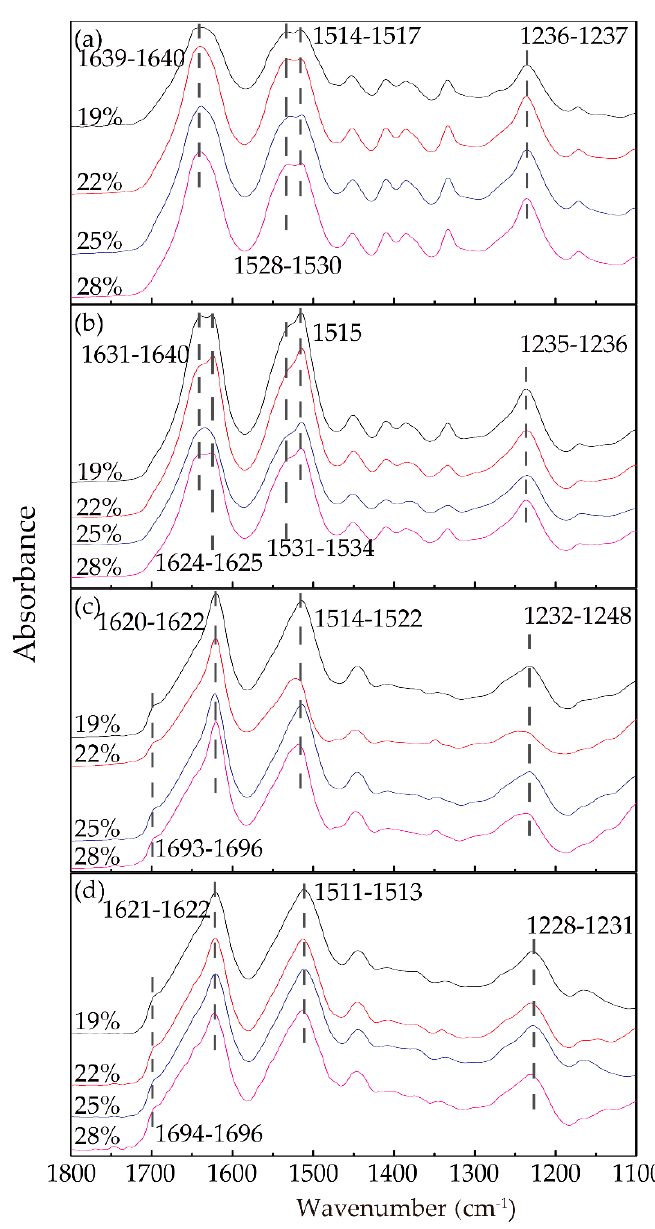
Figure 4. FTIR spectra of all the samples from the amide I to amide III bands: (a) F1; (b) F2; (c) E1; (d) E2.